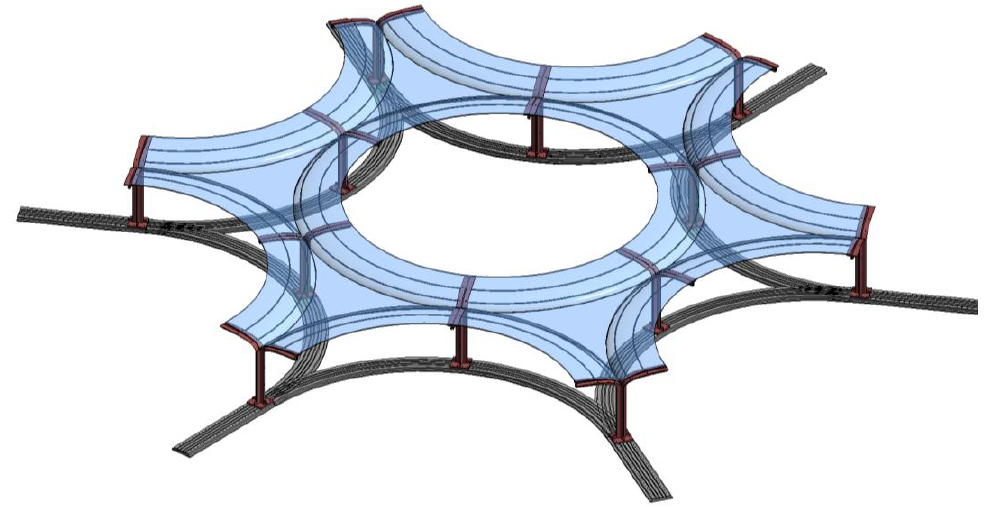
Figure 20. Spatial form of a radiative building.